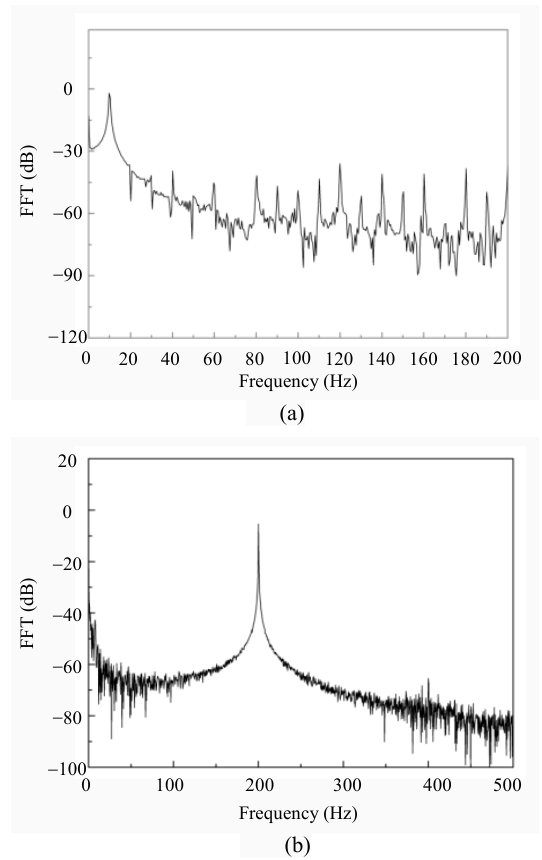
Fig. 6 Frequency domain signal of (a) 10 Hz and (b) 200 Hz.